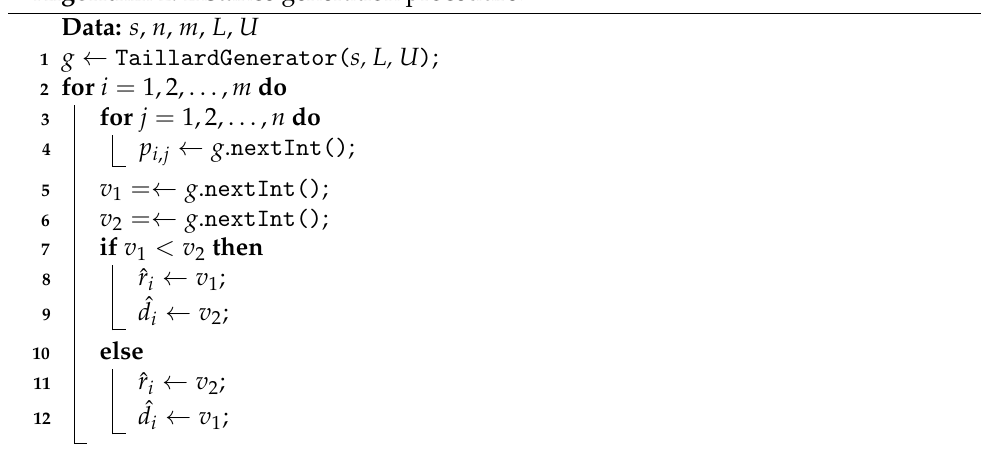
Algorithm 2: Instance generation